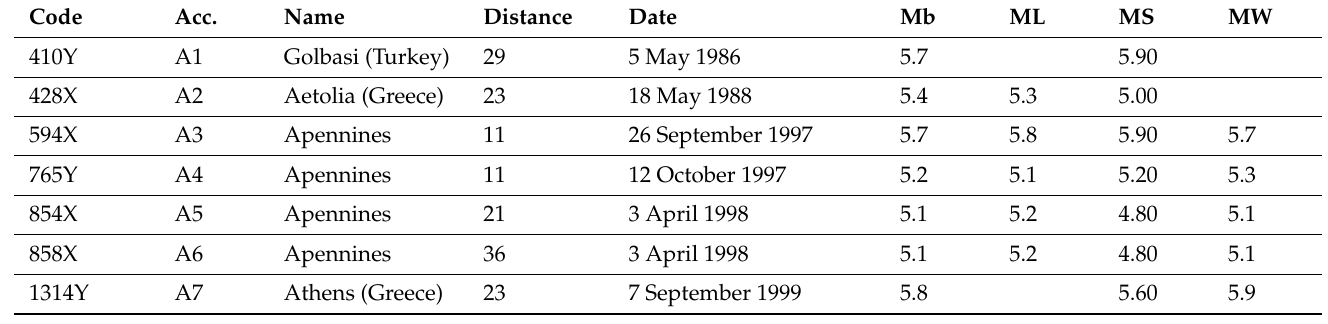
Table 4. Seismological characteristics of the selected accelerograms.